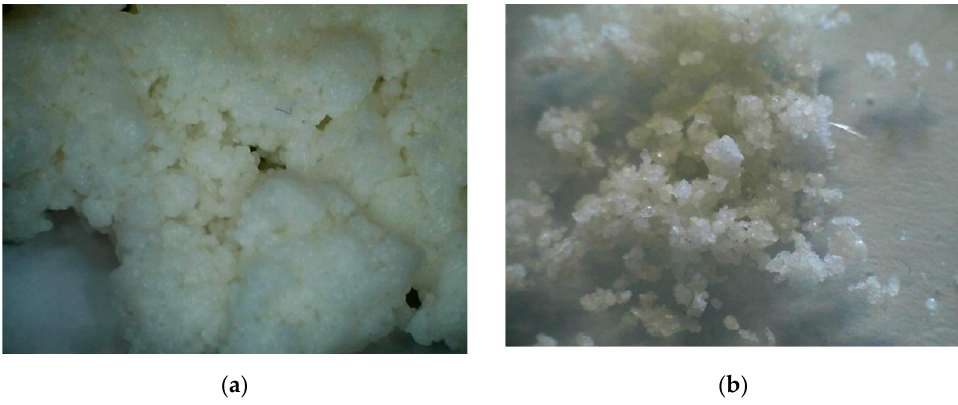
Figure 9. Photograph with a digital microscope: ( a ) wet Ge@12(E)-O-12(E) Cl; ( b ) dry Ge@12(E)-O-12(E).